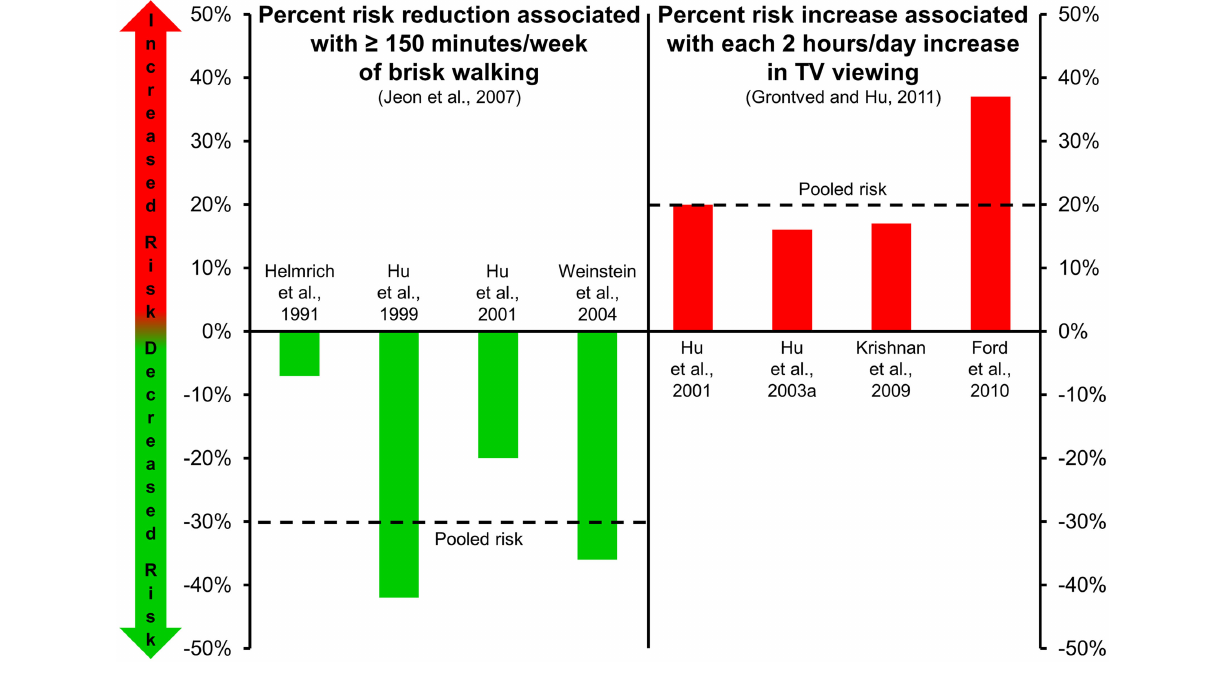
FIGURE 1 | Risk of type 2 diabetes associated with walking (left panel; Jeon et al., 2007) andTV viewing (right panel; Grontved and Hu, 2011). Dashed lines in each panel represent the pooled risk among the